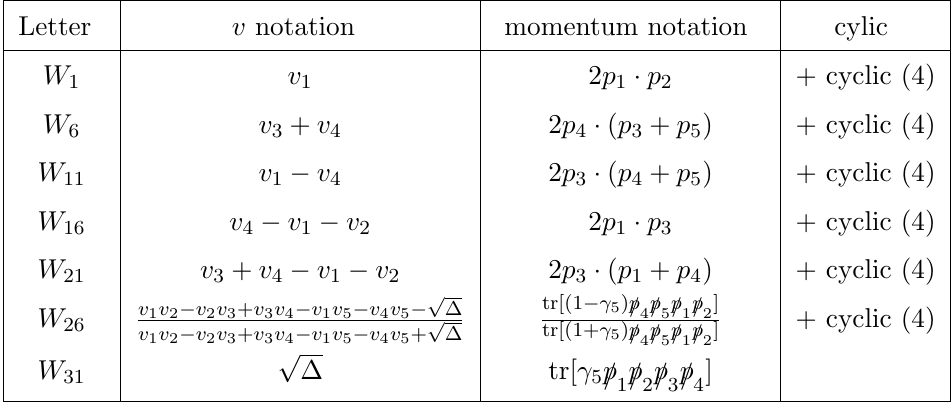
Table 2 . Interpretation of pentagon alphabet in terms of particle